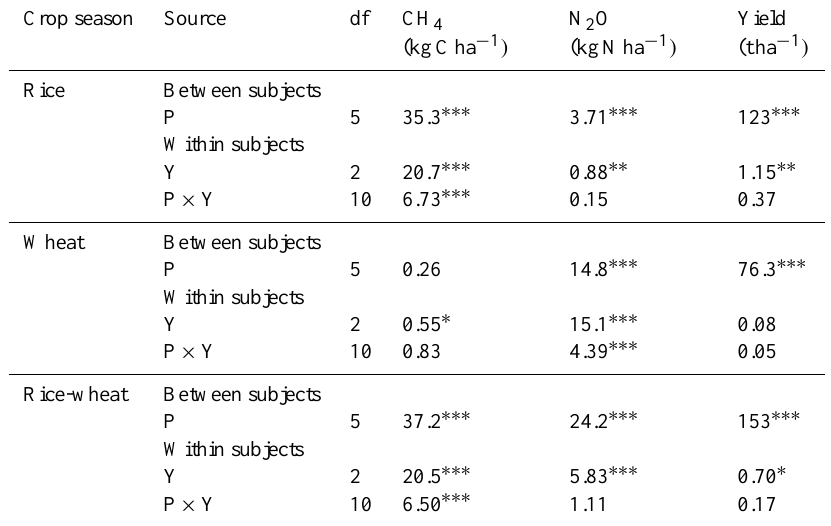
Table 4. Repeated-measures analysis of variance (MANOVA) for the effects of cultivation patterns (P) and cropping year (Y) on mean CH 4 and N 2 O emissions, and mean rice and wheat grain yields in the 2011–2014 cycle.